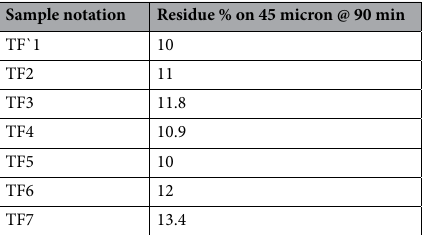
Sample notation